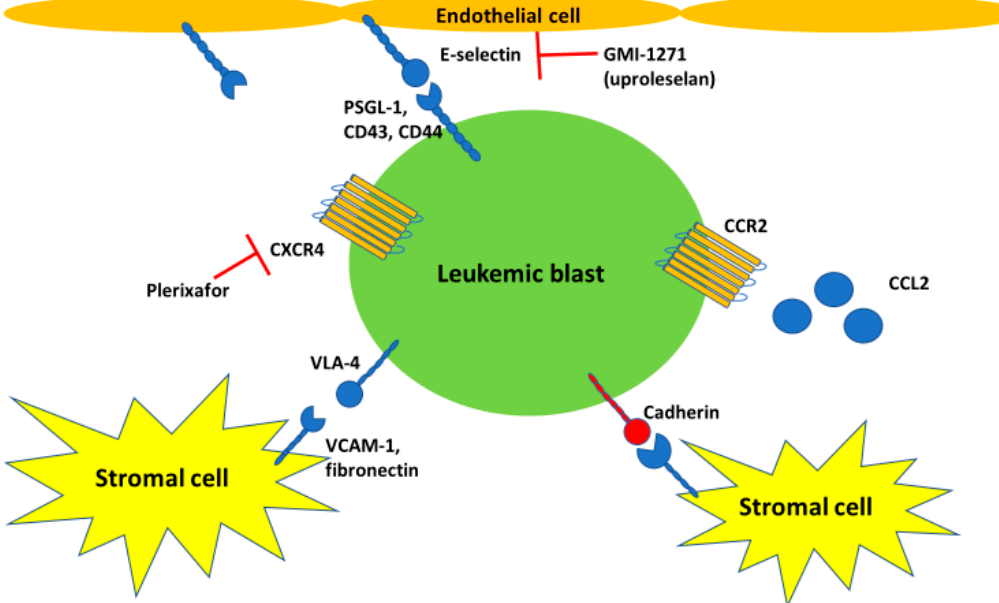
Figure 2. Selected interactions between leukemic blasts and other cells in the bone marrow niche: AML blasts interact via various mechanisms with bone marrow stromal cells and endothelial cells. Among those mechanisms are the interaction of chemokine receptor CXCR4 on leukemic blasts with its soluble ligand CXCL12 (also known as SDF-1), which can be blocked with plerixafor. Additionally, the interaction between E-selectin on endothelial cells and various ligands on leukemic cells such as PSGL-1, CD43, and CD44 has become an increasingly studied therapeutic target with GMI-1271 (uproleselan) currently being studied in advanced phase clinical trials. Other interactions between bone marrow stromal cells and both regular HSCs and leukemic cells include VLA-4 / VCAM-1, VLA-5 / fibronectin, and cadherins. Finally, the CCL2 / CCR2 axis has been shown to be expressed in the majority of monocytoid AML blasts and to play a role in cell proliferation [52].